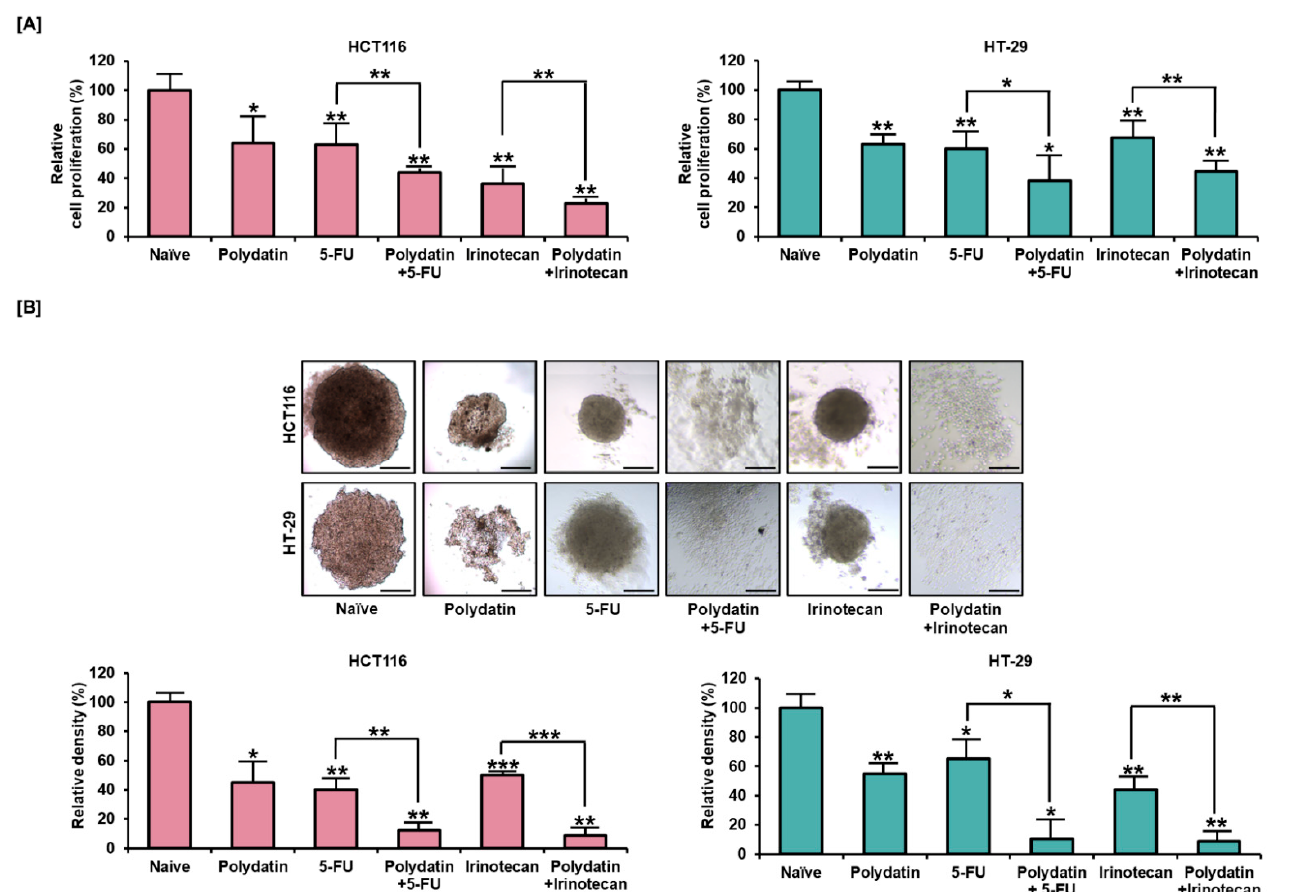
Figure 6. The synergetic effects of polydatin when added with accepted anticancer drugs, 5-FU, and irinotecan. ( A ) The suppressive effects of polydatin on the proliferation of colon cancer cells when combined with 5-FU and irinotecan. ( B ) The spheroids of HCT116 and HT-29 were observed by cotreating polydatin with anticancer drugs. The relative density of spheroid formed in colon cancer cells was calculated using ImageJ. Scale bar: 100 μ m. The asterisks symbolize statistical differences among diverse groups (* p < 0.05, ** p < 0.01, and *** p < 0.001).